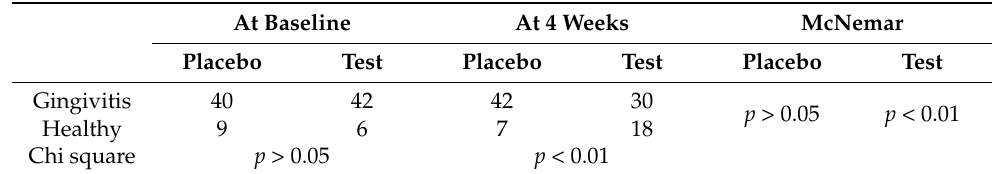
Table 3. Changes in number of patients diagnosed with gingivitis by groups. Chi-square test was used for comparing gingivitis prevalence between placebo and TEES-10 ® intake group in same time period. McNemar test was used for comparing gingivitis incidence between baseline and 4 weeks after TEES-10 ® or placebo intakes in each group. At Baseline At 4 Weeks McNemar Placebo Test Placebo Test Placebo Test Gingivitis 40 42 42 30 p > 0.05 p < 0.01 Healthy 9 6 7 18 Chi square p > 0.05 p < 0.01